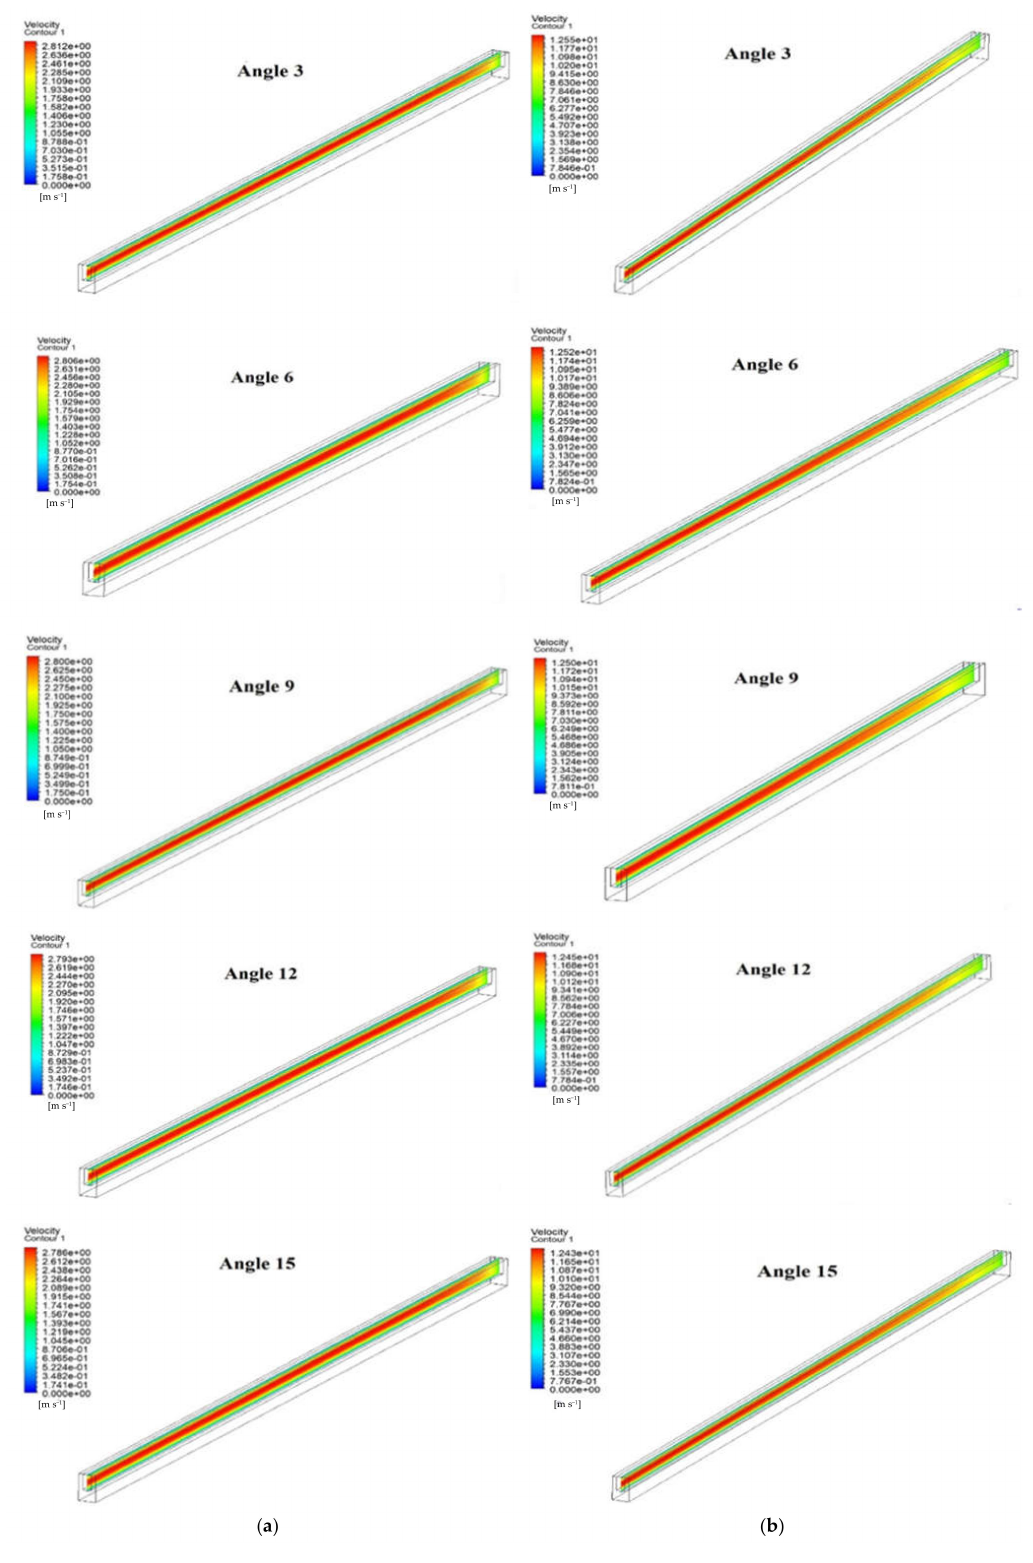
Figure 5. Velocity Contour in microchannel at ( a ) Reynolds Number = 200 and ( b ) Reynolds Number =